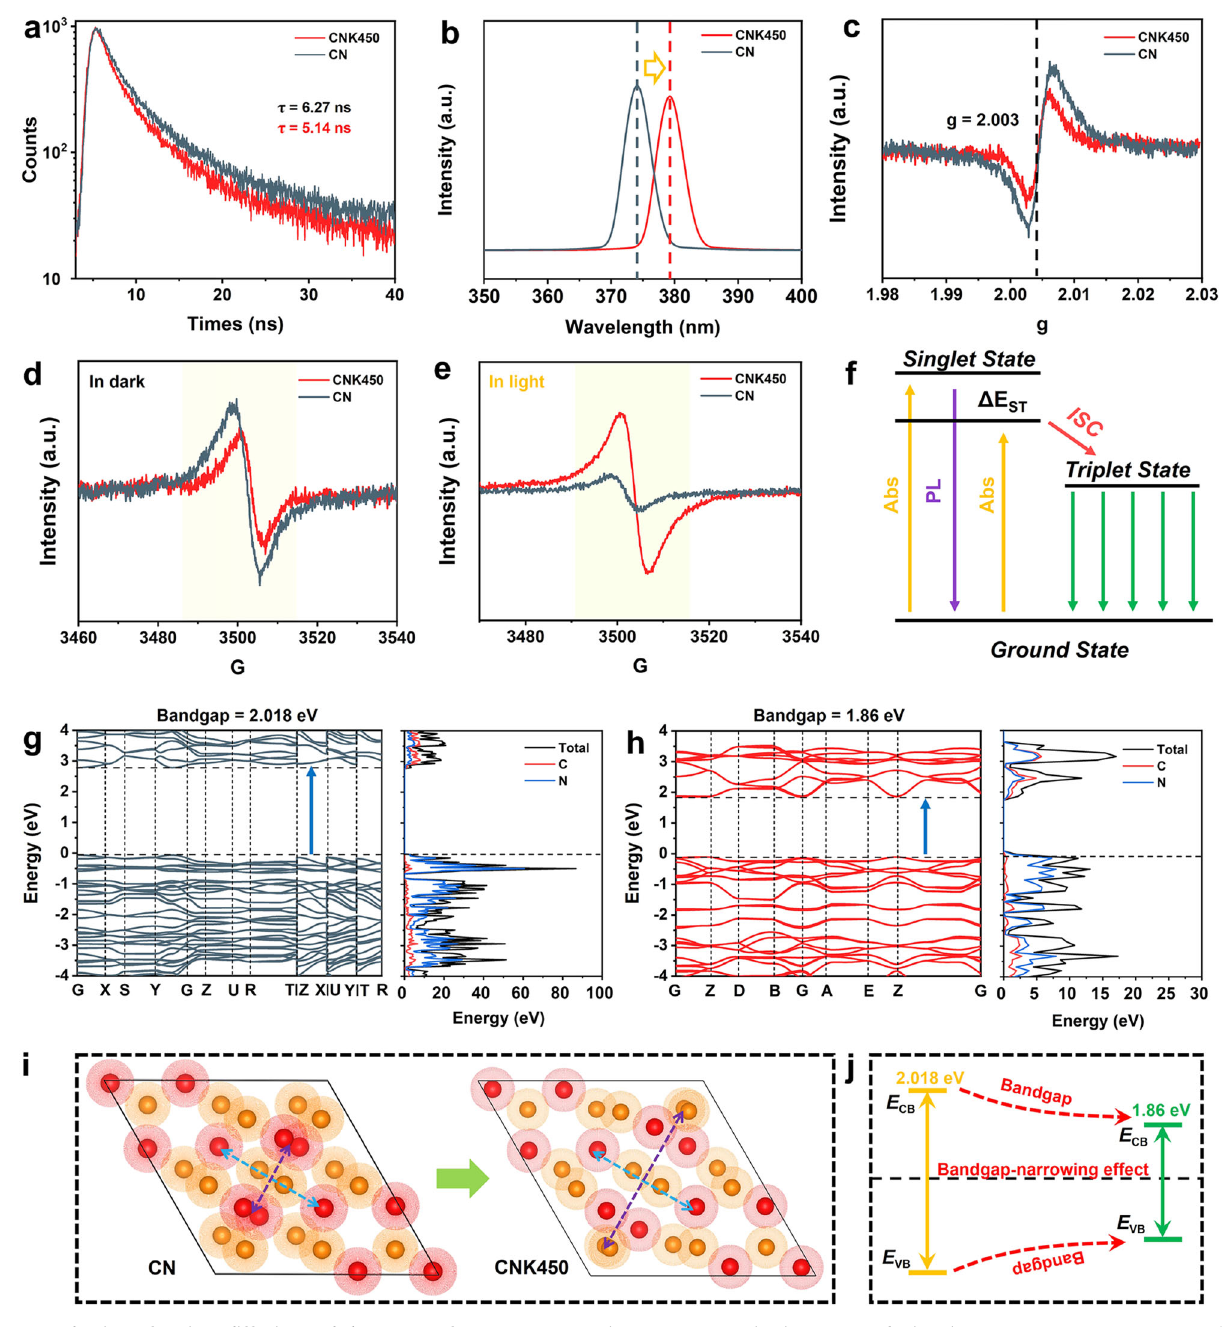
Fig. 3 Mechanism of exciton diffusion and charge transfer process. a Steady-state time-resolved PL spectra. b Photoluminescence Emission spectra. (The orange arrow represents the shift of peak). EPR spectra are shown in c ; EPR spectra in the dark are in d and in the light in e . f Illustration of the charge transfer process of samples. Calculations of band structure and density of states (DOS) of g CN and h CNK450. i Illustrations of the samples ’ structural change. j Samples ’